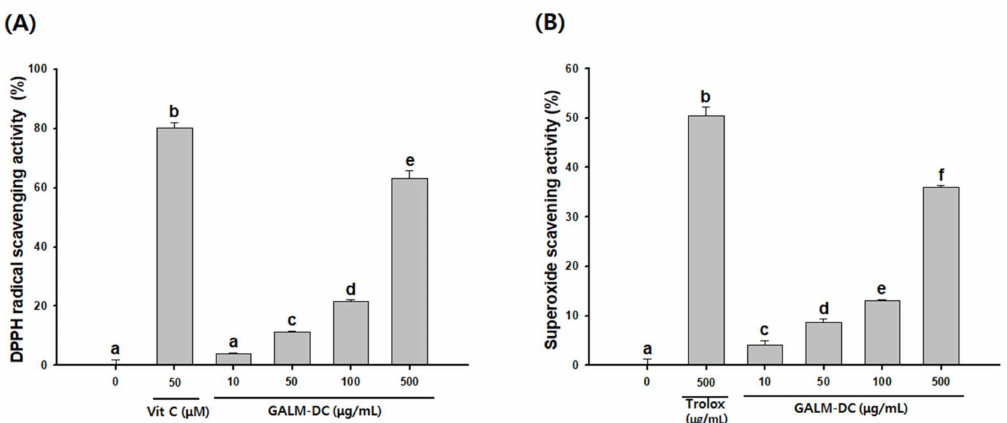
Figure 3. Anti-oxidant activities of GALM-DC on various radicals determined by ( A ) DPPH radical scavenging activity and ( B ) superoxide scavenging activity. Vitamin C ( A ) and trolox ( B ) were used as positive controls. Data are presented as mean ± SD. Values with di ff erent letters (a–f) are significantly di ff erent one from another (one-way ANOVA followed by Tukey’s multiple range test, p < 0.05) sarcopenia.